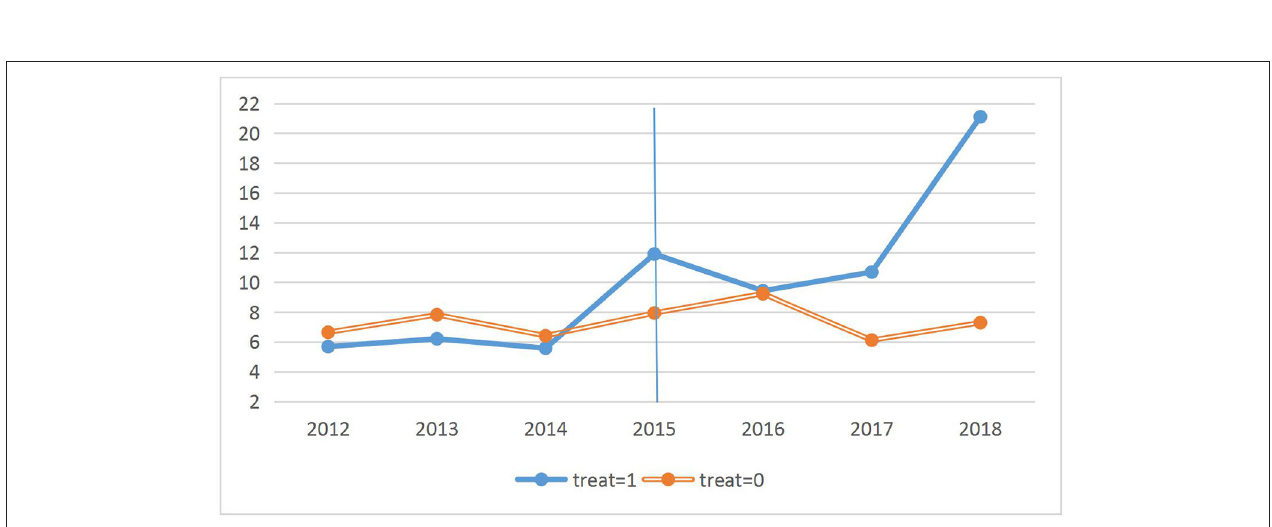
FIGURE 2 | Parallel trends of green innovation of enterprises (regions with low degrees of fiscal decentralization).